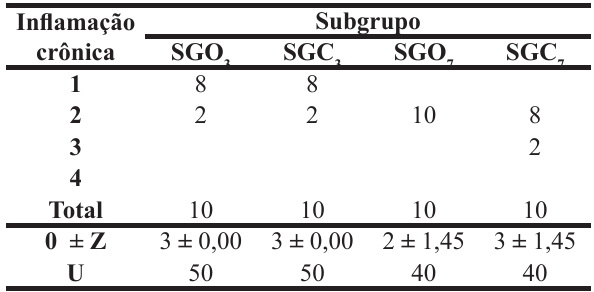
TABELA 3 – Intensidade da inflamação crônica nos animais dos subgrupos controle e Orbignya , analisada nos 3º e 7º dias do período pós-operatório.